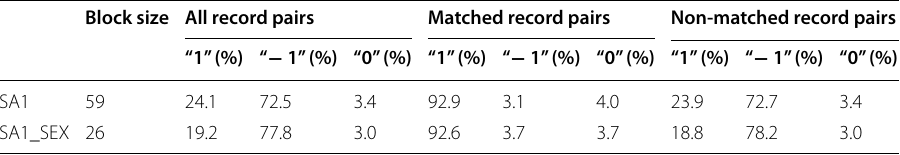
Table 2 Percentage of agree, disagree and missing for each blocking variable Block size All record